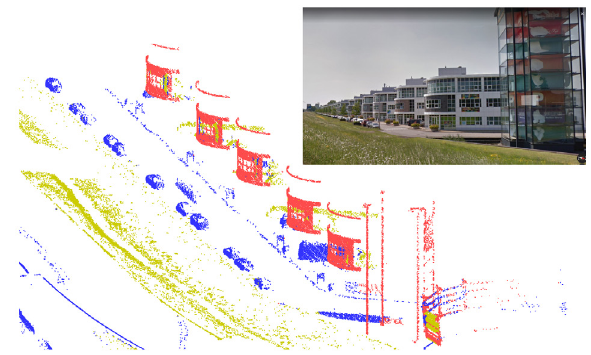
Figure 12. Remaining points near buildings are automatically assigned to buildings (red), objects above the road including cars, pedestrians (blue), points above terrain polygons (yellow). The MLS points in the remaining class just above the road belong selection and growing. These points are further analysed in section 3.5 and 4.